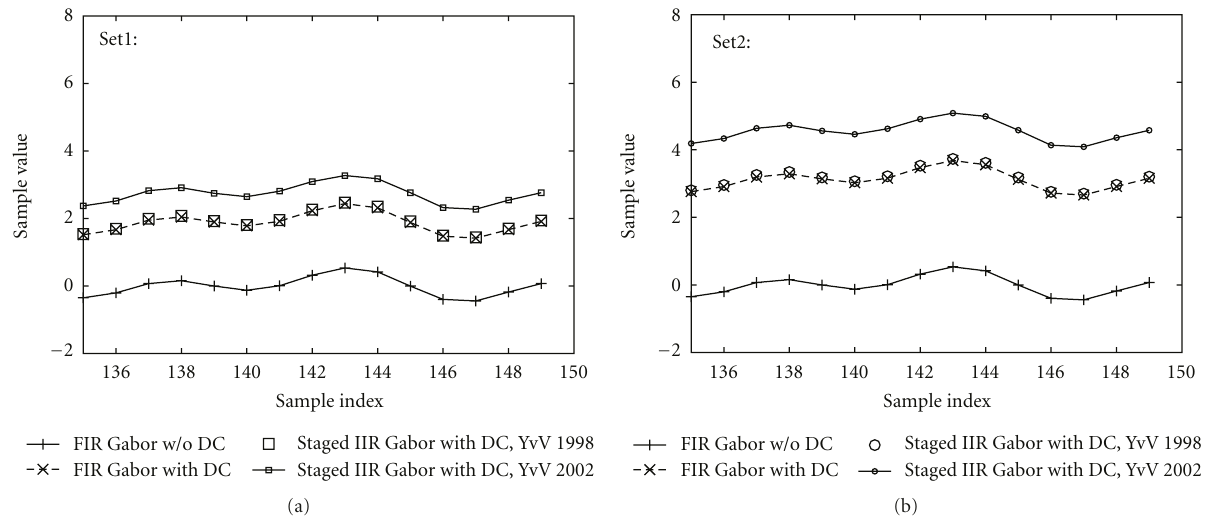
Figure 7: Comparison of results of the same Gabor filter computed with di ff erent filtering without the zero-mean correction, denoted as with DC . Two input images were used: One was randomly generated, denoted as Set1 , while the second is a copy of the first one with a constant value added to every image position. We may also notice how di ff erently respective filtering variants respond to the change of mean value of input data, which is a result of di ff erent approximations involved in the respective variants. Only real parts of the complex filtering results are shown